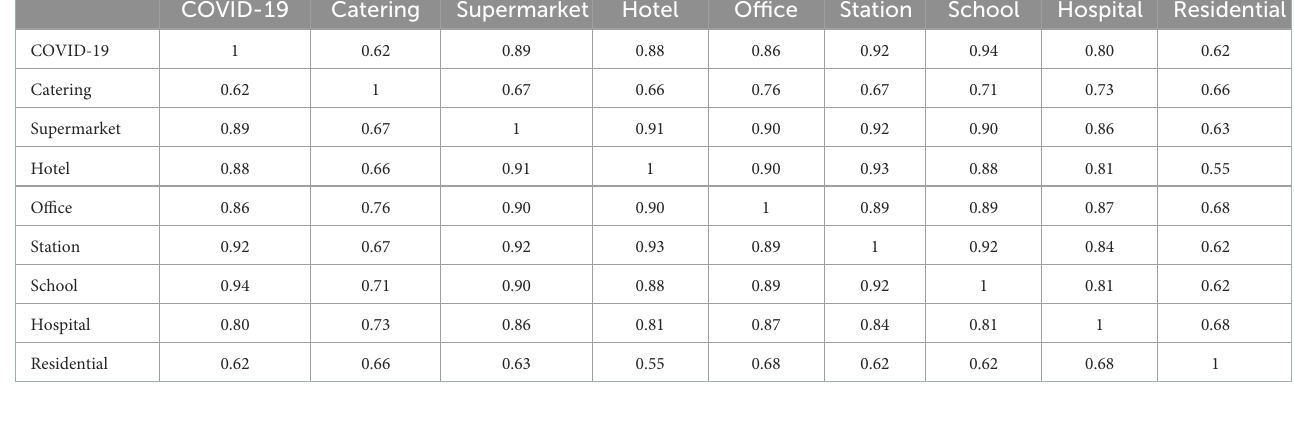
TABLE 3 Comparison of COVID-19 footprint and different types of POI similarity.